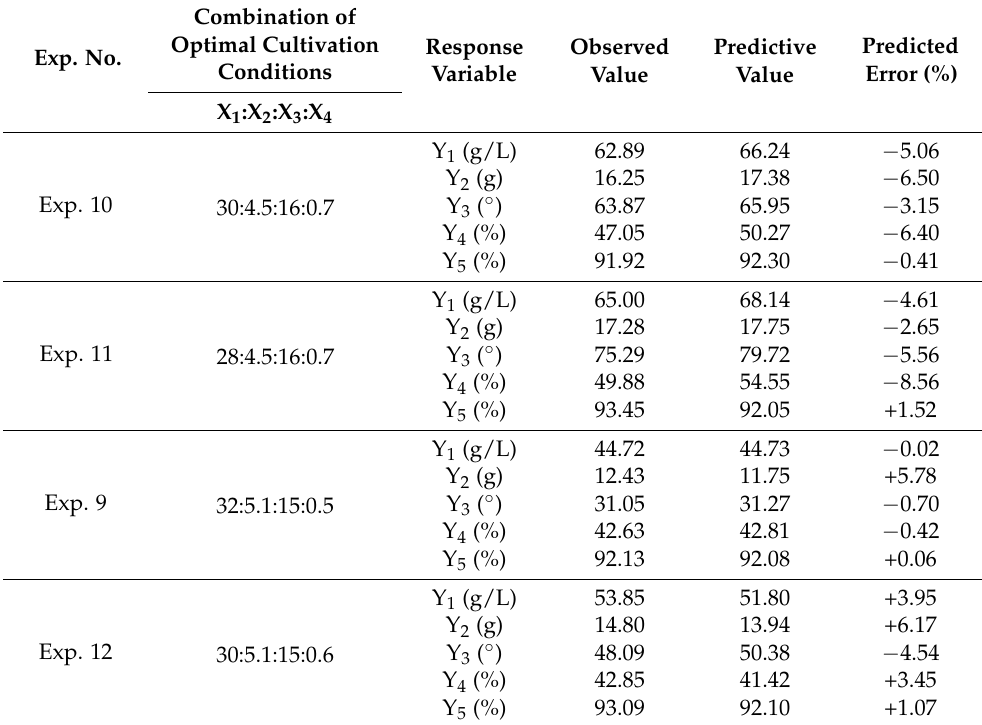
Table 6. Combination of optimal cultivation conditions and the observed (experimental) and pre- dicted (theoretical) response variable